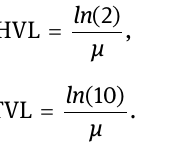
Figure 7: The TVL distribution with the gamma - ray energies.